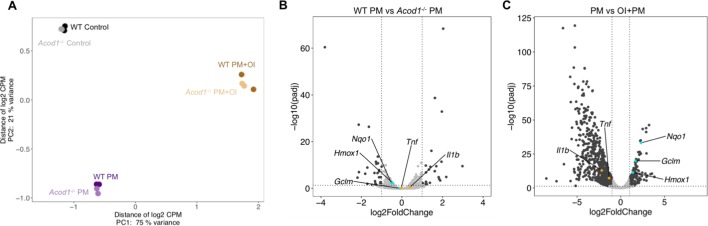
Endogenous and exogenous Itaconate have different effects on transcriptomic changes in response to PM.(A) PCA plot showing top 500 of 10,250 low expression removed gene features in WT or Acod1-/-BMDMs treated with PM and/or OI for 24 hours. (B–C) Volcano plots showing differentially expressed genes (DEGs) in (B) PM-treated Acod1-/- BMDMs compared with PM-treated WT BMDMs (51 DEGs), and (C) OI and PM-treated WT BMDMs compared with only PM-treated WT BMDMs (1,030 DEGs). DEGs were identified using DESeq2 at FC > 2 and FDR adjusted p-value of p<0.05. Dark gray points represent significantly different genes; light gray points represent not significantly different genes. Inflammatory genes (orange) and NRF2 target genes (turquoise) were not significantly different between WT and Acod1-/- BMDMs, while OI-pretreated BMDMs significantly expressed fewer inflammatory genes and more NRF2 target genes compared to BMDMs without OI pretreatment.
Figure 6—source data 1.Table of gene feature counts for all samples as generated using featureCounts.

Figure 6—source data 2.Differential expression analysis results of PM treated Acod1-/- BMDMs compared with PM treated WT BMDMs.

Figure 6—source data 3.Differential expression analysis results of OI and PM treated BMDMs compared with only PM treated BMDMs.